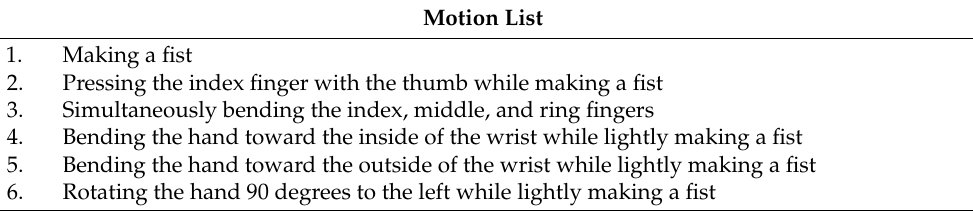
Table 2. List of 10 motions of